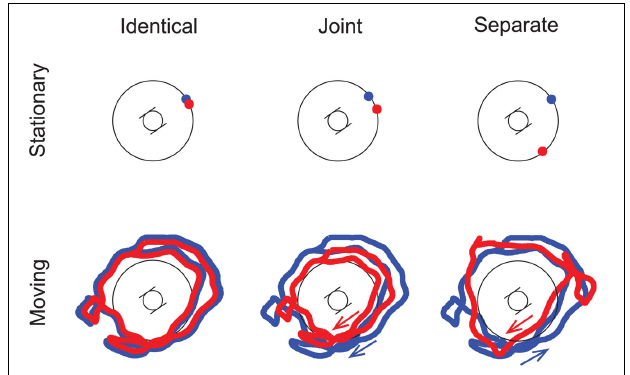
FIGURE 1 | Schematic illustration of the spatial trajectories of the sound sources. The artificial head was placed at the center of the stage, and listeners perceived the stimuli as if sitting in this position. The two trajectories are drawn in red and blue. For Joint and Separate motion, arrows indicate the direction of movement for each trajectory. Note that the trajectories are illustrations only; they do not depict the actual recordings. (Adapted by permission from Figure 1, B˝ohm et al.,